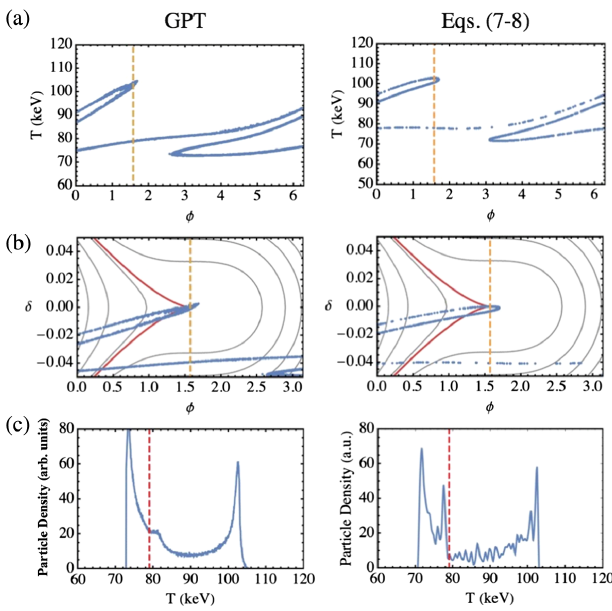
FIG. 7. Final phase space distribution over one structure period of a GPT simulated beam immediately after exiting the tapered MLA including (a) the final beam energy vs phase distribution, (b) the phase space plot superimposed with Hamiltonian level sets and sepatratrix (in red), and (c) the corresponding energy spectrum of the full beam with the initial energy marked in red. Left column, GPT particle tracking results; right column, resonant particle model from Sec.